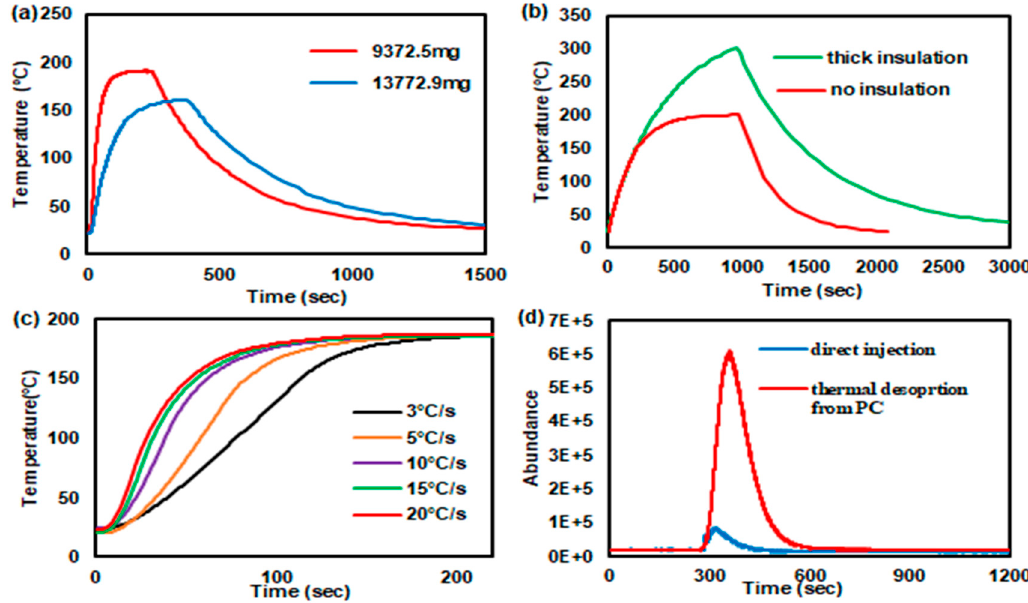
Figure 6. Temperature profiles of the SS PC (SS316 / BN) ( a ) with di ff erent thermal mass (no insulation); ( b ) with and without thermal insulation (9372.5 mg sample); ( c ) a family of the temperature profiles of the SS PC with di ff erent heat ramping rates; ( d ) the mass spectrometer responses for the direct splitless injection of 0.5 mL of 0.6% headspace toluene (blue line) and for the thermal desorption peak of toluene after sampling of 10 mL of 0.6% headspace toluene into the SS PC.